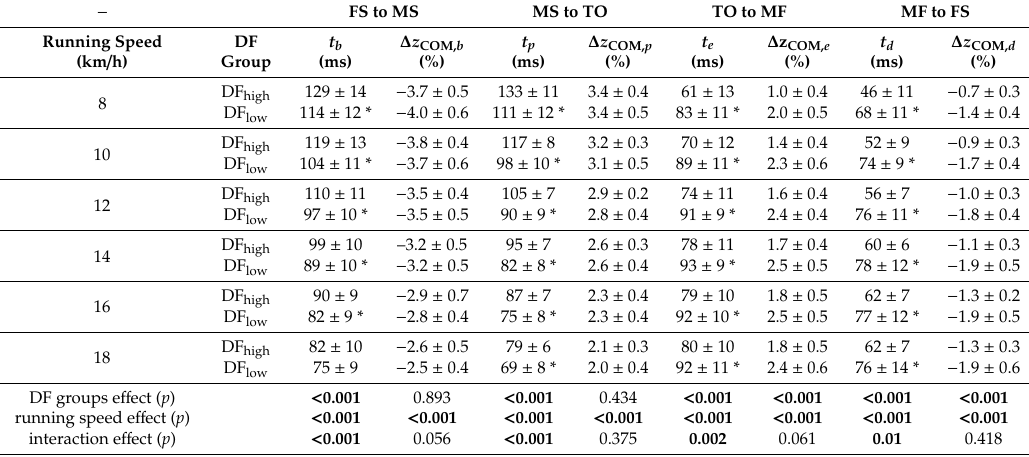
Table 2. Temporal parameters ( t b , t p , t e , and t d ) of the running step and vertical displacements ( ∆ z b , ∆ z ∆ z ∆ z p , e , and d ) of the center of mass (COM) during the running step for the high (DF high ) and low (DF low ) duty factor running groups at the di ff erent running speeds. − FS to